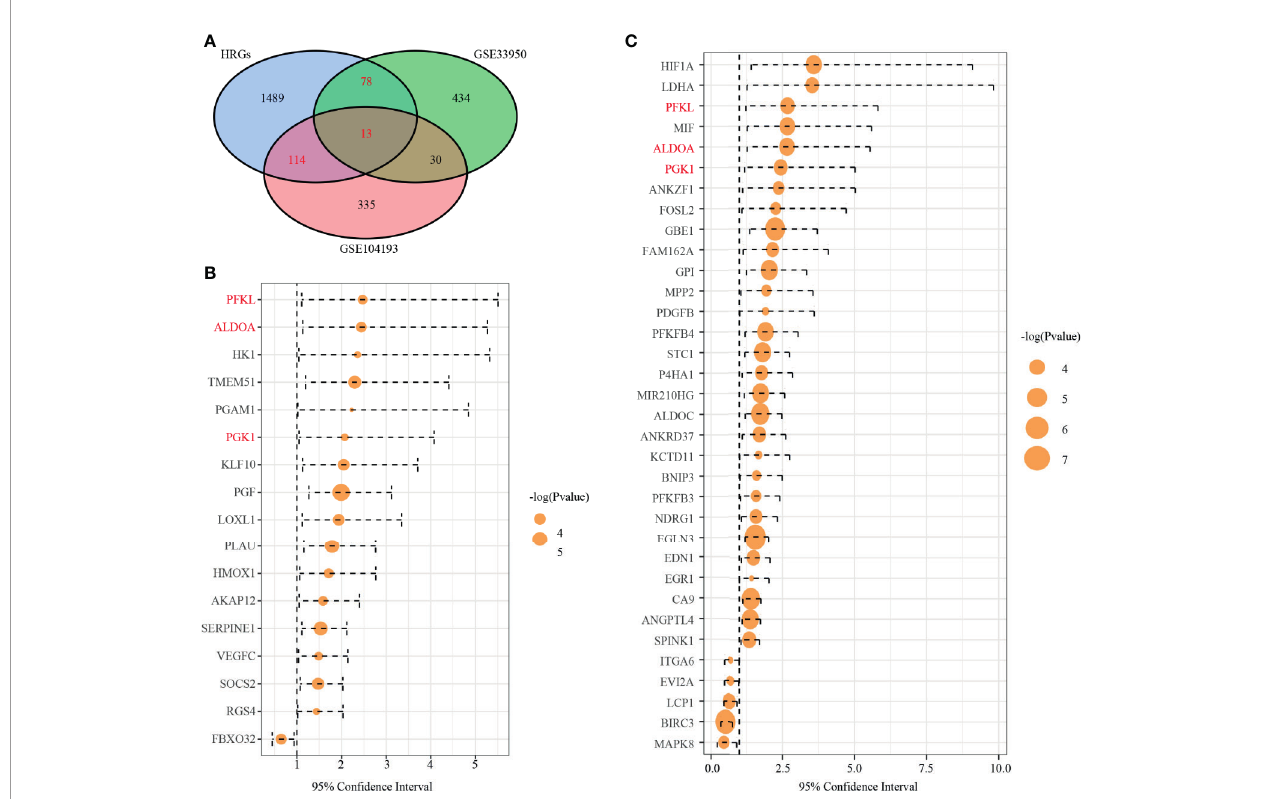
FIGURE 2 | Identi fi cation of prognostic TNBC-speci fi c hypoxia-related genes (HRGs). (A) Venn diagram of the 13 TNBC-speci fi c HRGs, which are the genes in the intersection of the HRGs from MSigDB and the DEGs of GSE13041 and GSE33950. (B) Hazard ratio (HR) of univariate survival analysis of HRGs in TCGA-TNBC. (C) HR of univariate survival analysis of HRGs in GSE13041. (Genes with p -value < 0.05 are shown in B , C